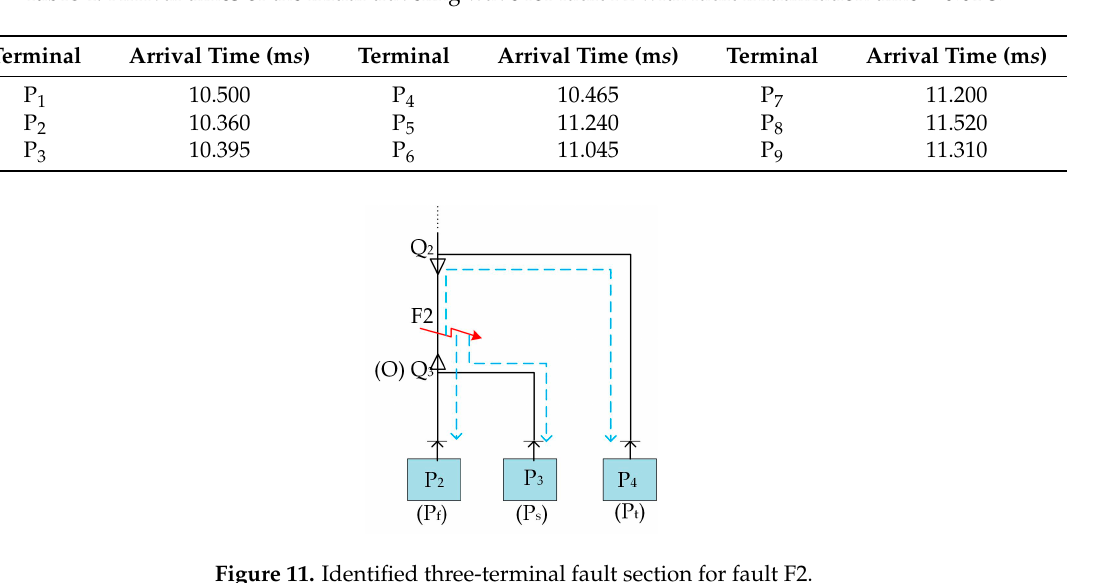
Table 4. Arrival times of the initial traveling wave for fault F2 with fault initialization time = 0.01 s.